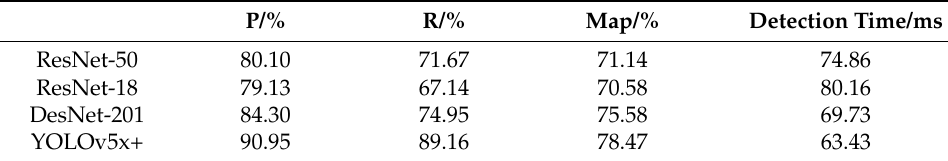
Table 3. Performance comparison of different